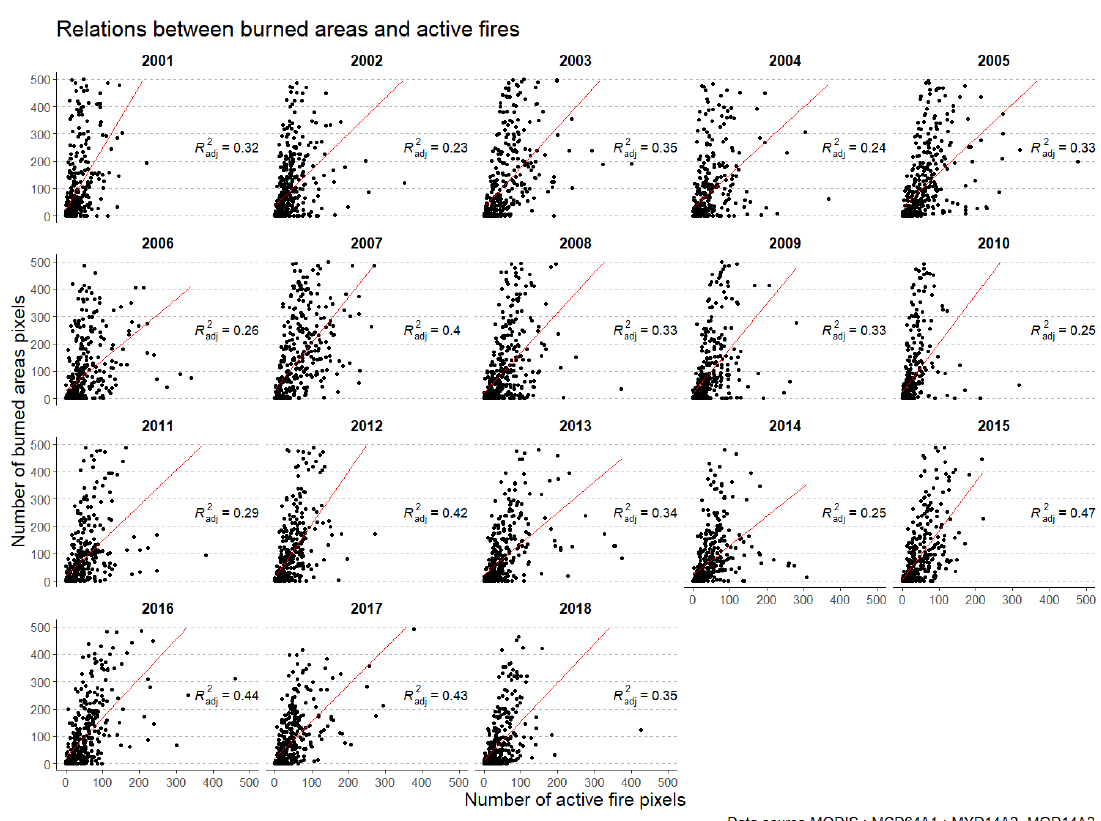
Figure A3. Correlation between burned areas and active fires.